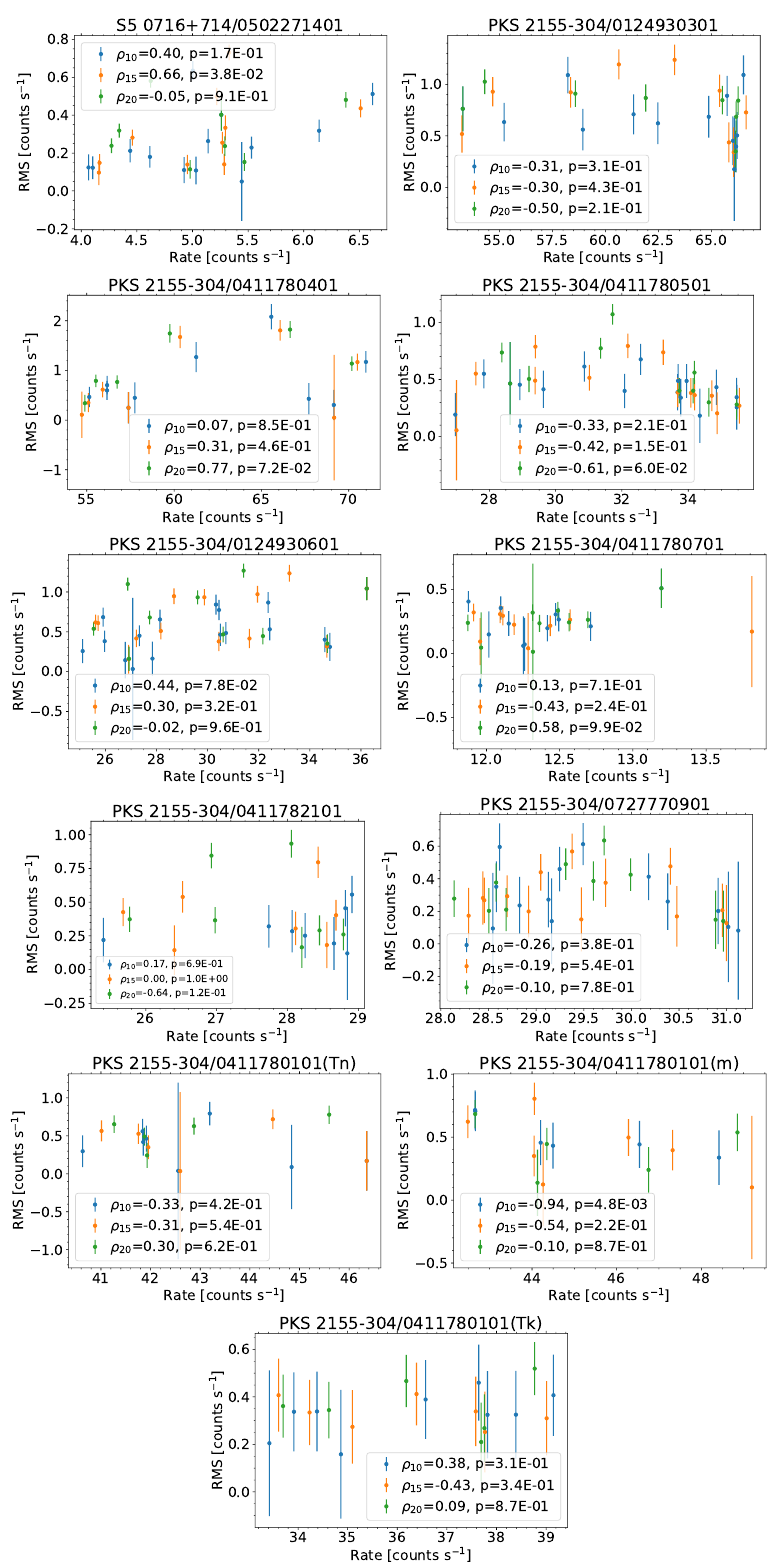
Figure 4. RMS-flux relation using 10, 15, and 20 data points per bin for each ID along with the corresponding Spearman correlation coefficient ( ρ ) and p